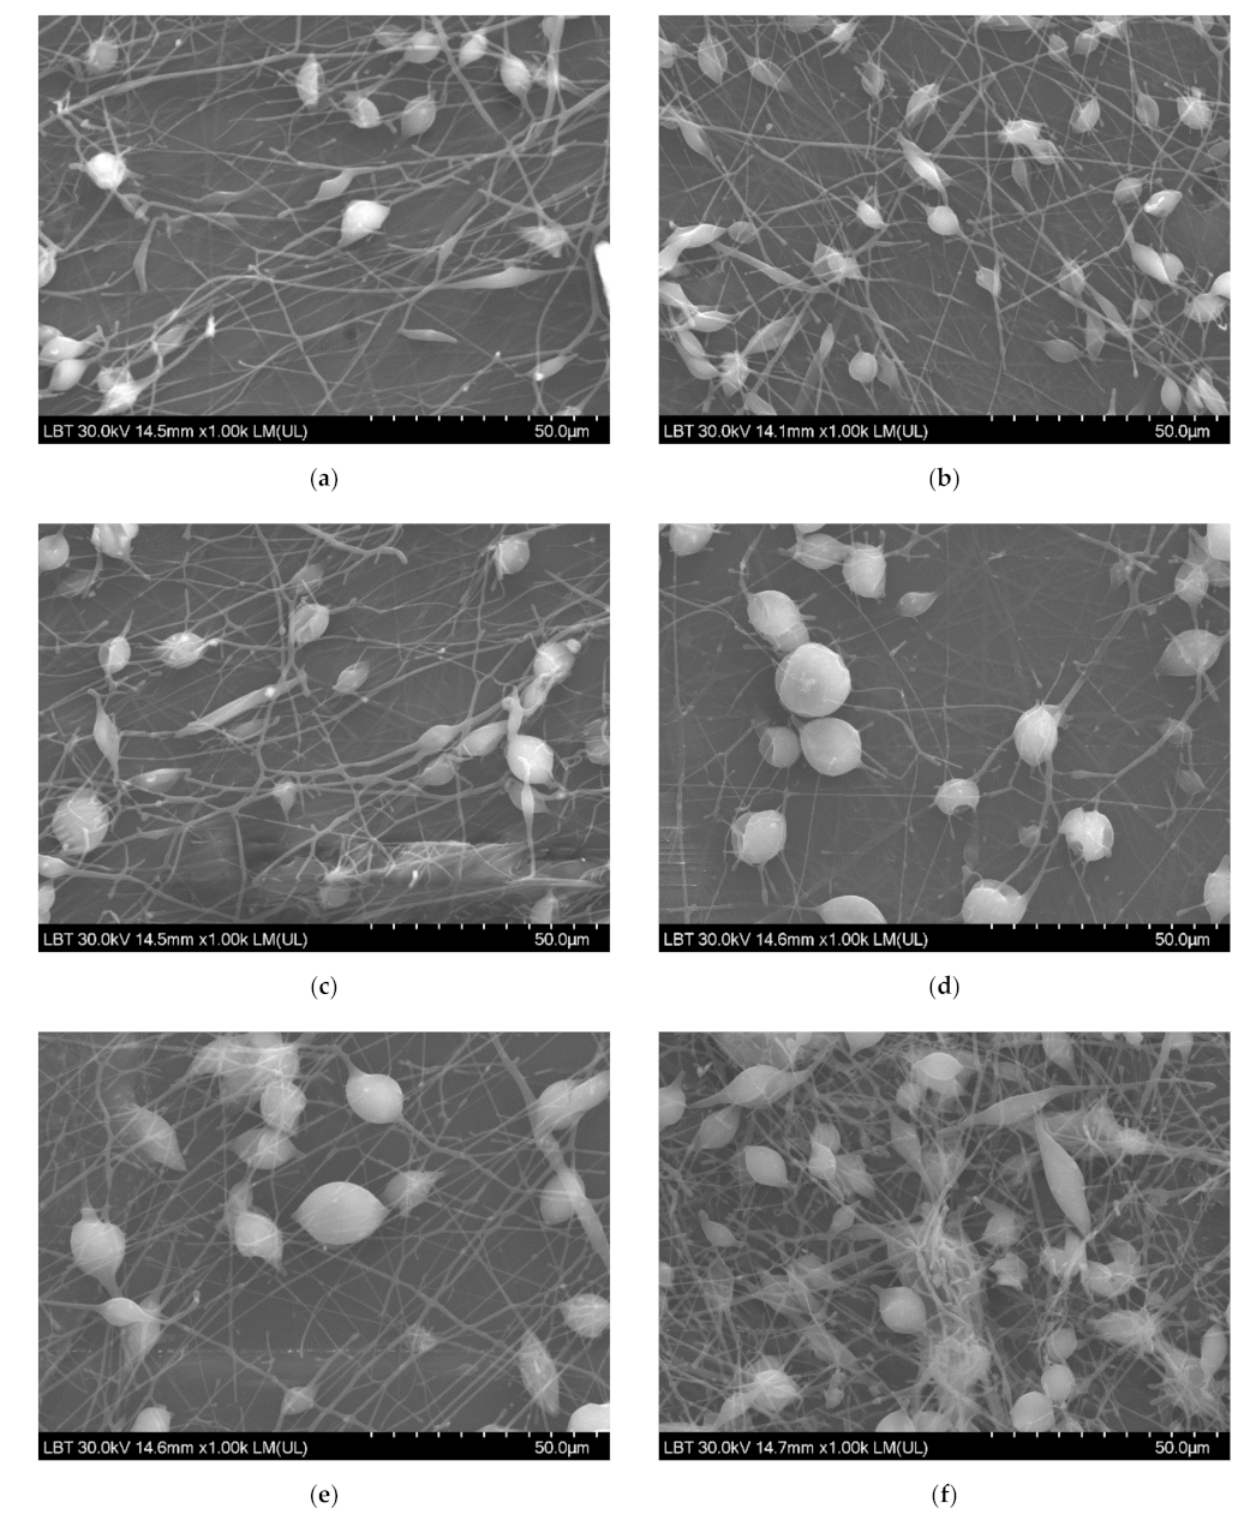
Figure 4. SEM images for PLA/PHBV/ZnO:Fex nanostructures: ( a ) PLA/PHBV, ( b ) PLA/PHBV/ ZnO:Fe0, ( c ) PLA/PHBV/ZnO:Fe0.3, ( d ) PLA/PHBV/ZnO:Fe0.5, ( e ) PLA/PHBV/ZnO:Fe0.7, and ( f )